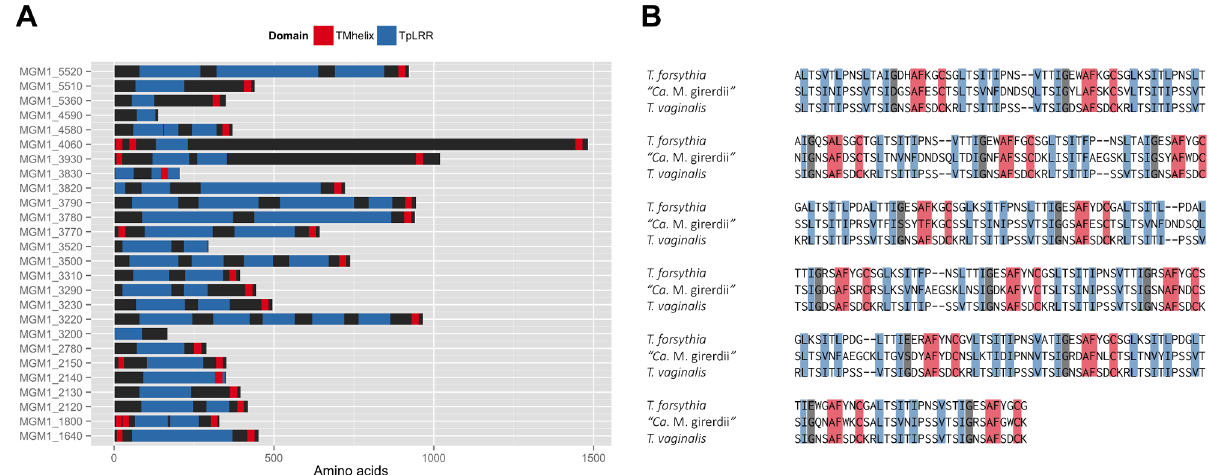
Figure 7. Expanded ‘‘ Ca . M. girerdii’’ BspA-like protein family. The diverse family of 26 BspA-like protein family members from the ‘‘ Ca . M. girerdii’’ strain VCU_M1 is depicted in panel (A). Predicted transmembrane domains and TpLRR domains are represented. An alignment of TpLRR domains from Tannerella forsythia BspA (AAC82625.1, bases 382–1347), ‘‘ Ca . M. girerdii’’ strain VCU_M1 MGM1_3780 (bases 449–782) and T.vaginalis BspA-like TVAG_495790 (XP_001327783.1, bases 112–1077) is shown in panel (B).